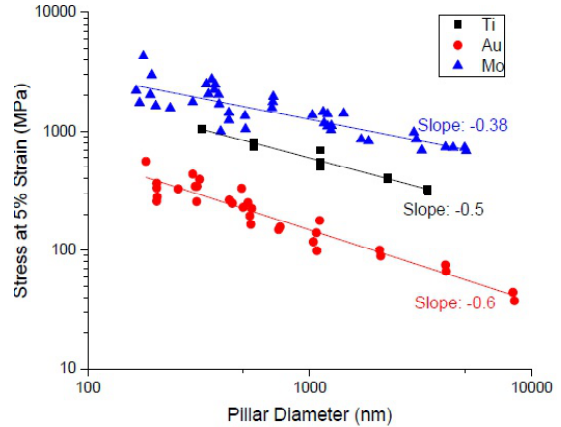
Fig. 7. Size effect on the strength of FIBed pillars (strength is taken as the flow stress at 5% plastic strain). Adapted from [55] and